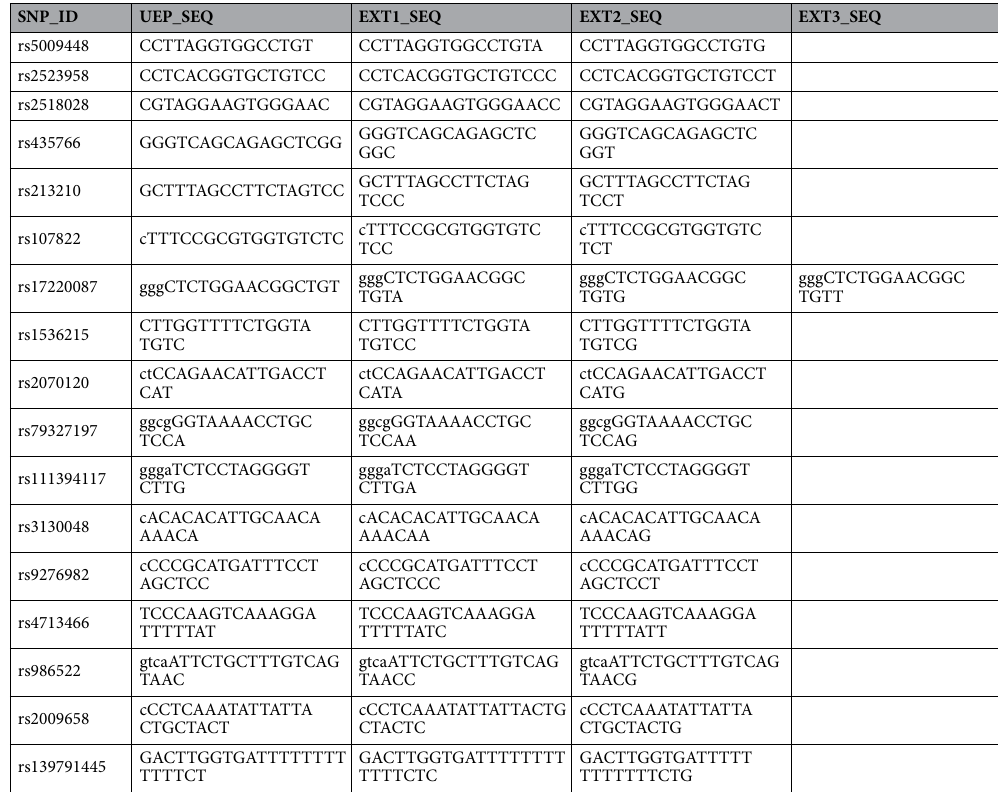
Table 6. The primers of the 17 SNPs used for the extension step of MassARRAY. UEP_SEQ: unextended primer sequence; EXT1_SEQ: extension primer sequence 1; EXT2_SEQ: extension primer sequence 2; EXT3_ SEQ: extension primer sequence